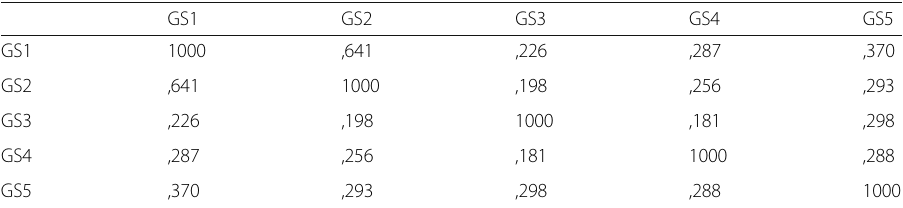
Table 6 Correlations on Generic Skills